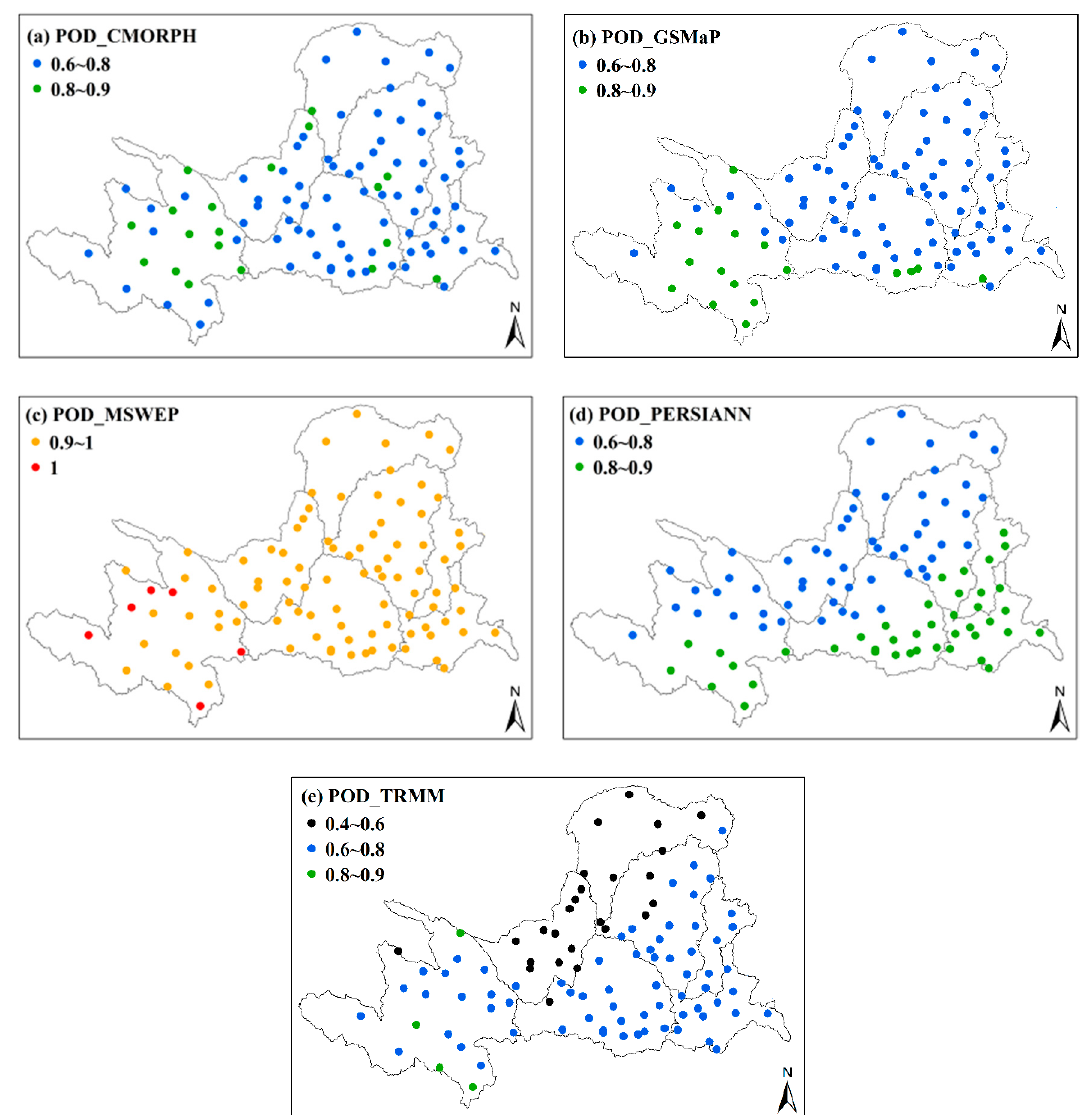
Figure 6. Detective ability of precipitation event: ( a ) POD, ( b ) FBI, ( c ) FAR, ( d ) TS and detective ability of precipitation: ( e ) correlation coefficient, ( f ) root mean square error, ( g ) PBIAS. POD is probability of detection, FBI is the frequency bias index, FAR is false alarm ratio, CC is correlation coefficient, RMSE is root mean square error, PBIAS is bias.